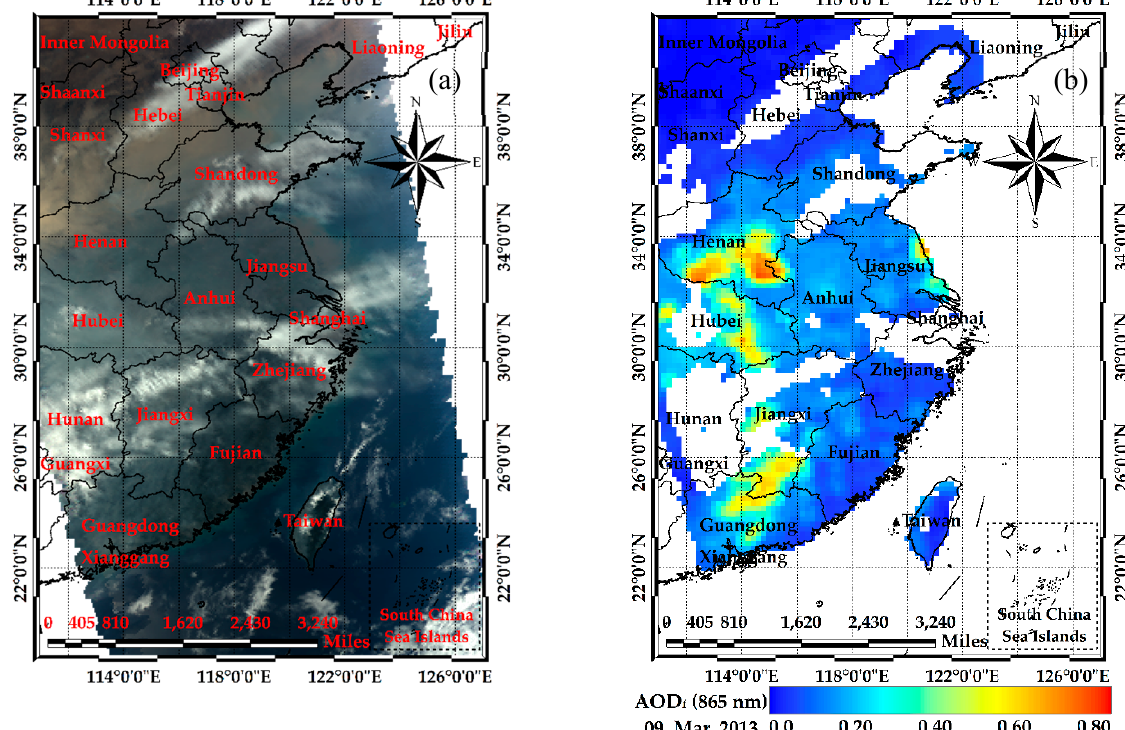
Figure 4. The AOD f retrieval result for 9 March 2013. ( a ) is a true color image and ( b ) is the AOD f (865 nm) result.